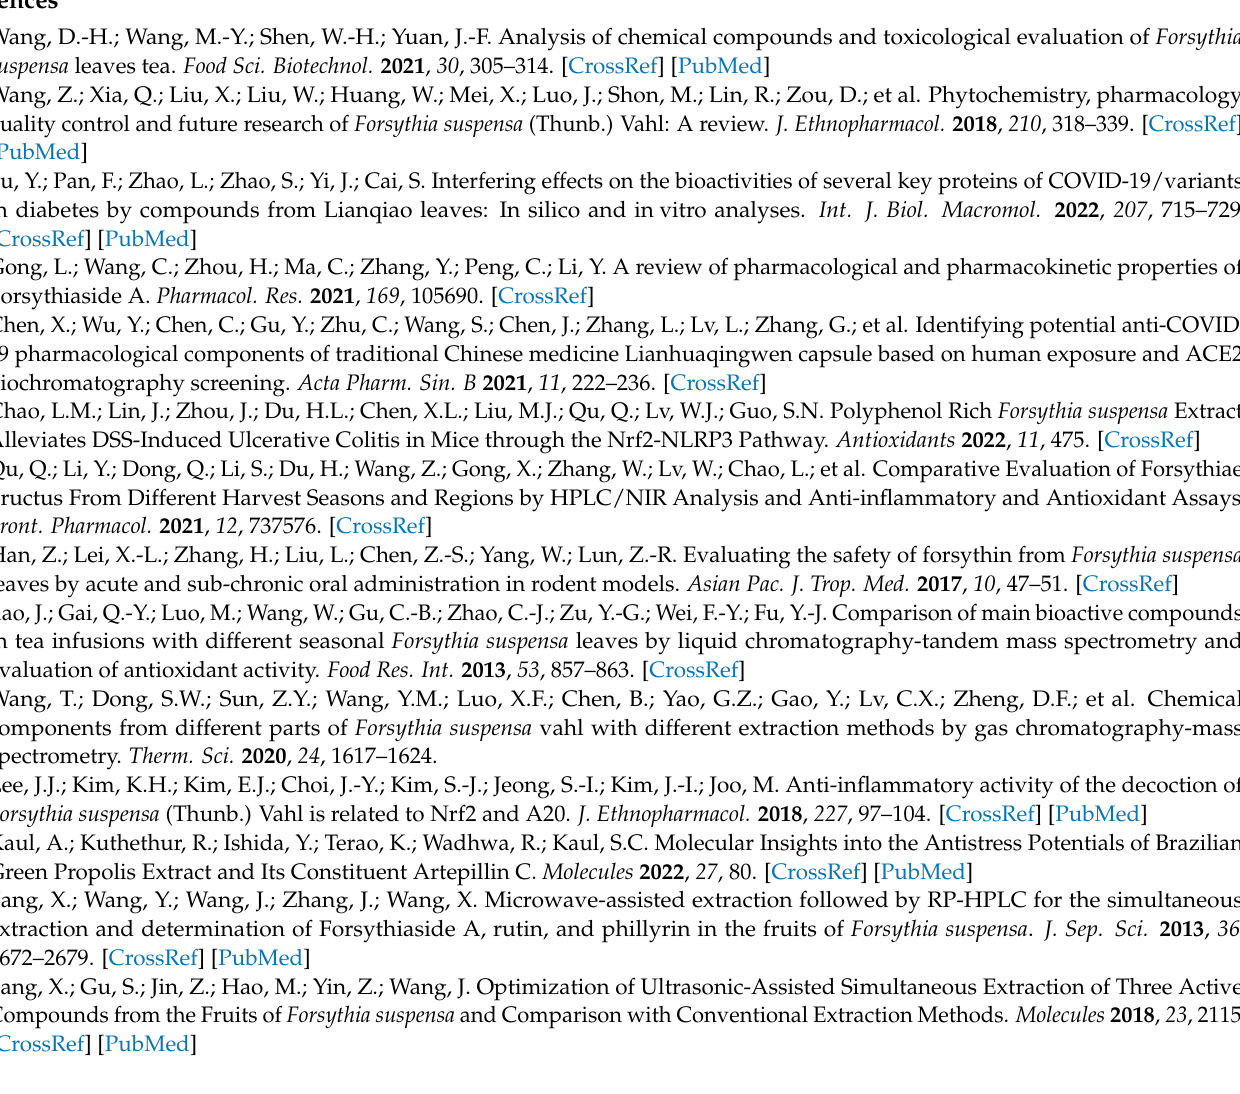
Table S4: Analysis of variance (ANOVA) for the developed second-order polynomial models on pure-water extraction of Forsythia suspensa